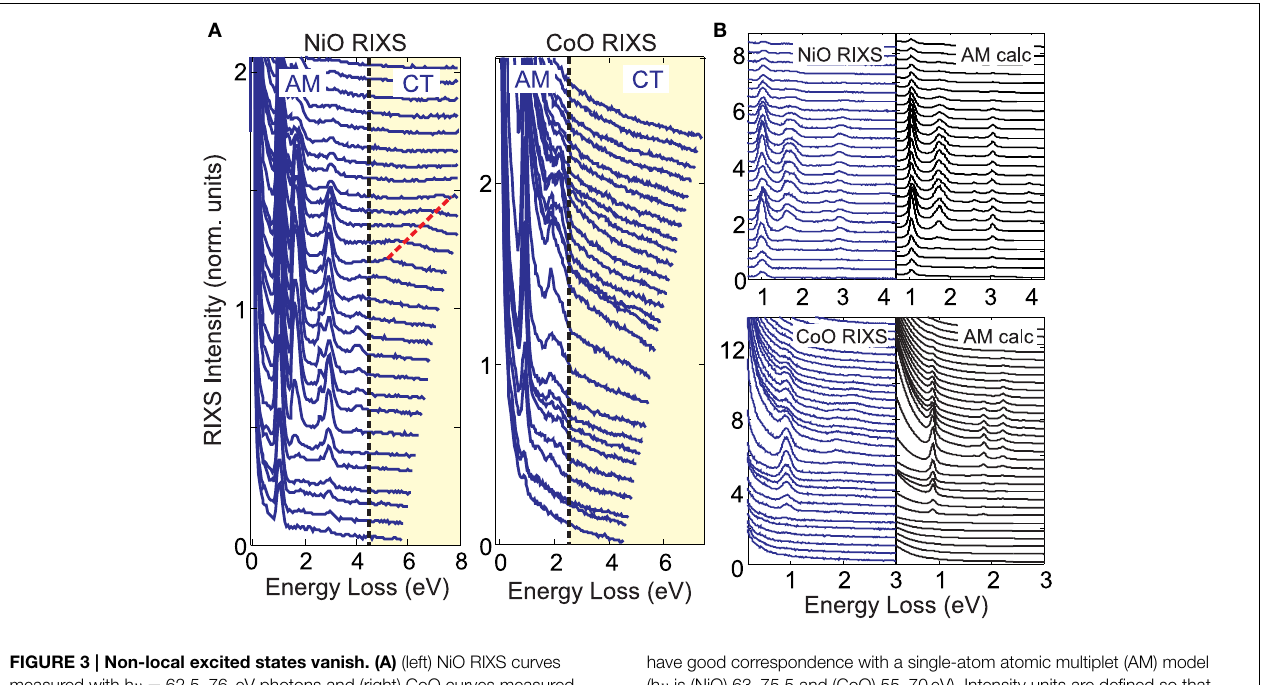
FIGURE 3 | Non-local excited states vanish. (A) (left) NiO RIXS curves measured with h ν = 62.5–76 eV photons and (right) CoO curves measured at h ν = 56.5–69.5eV (0.5eV step) are shown on an expanded scale that emphasizes the yellow-shaded high energy loss region. The band gap is indicated with a dashed line. (B) RIXS data beneath the charge transfer gap